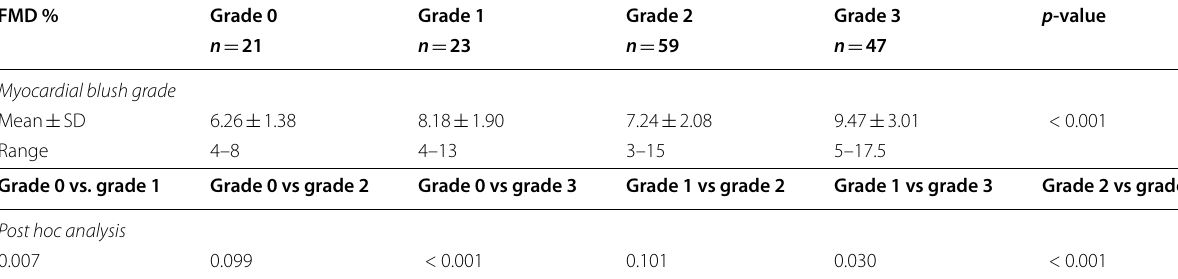
Table 4 Comparing FMD% between post-procedural